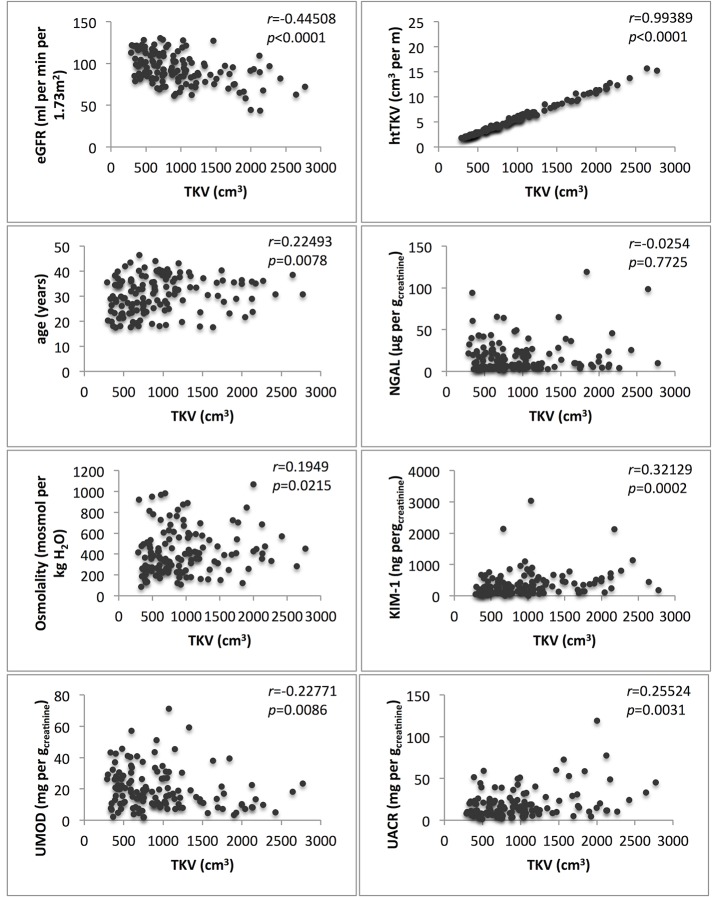
Total kidney volume (TKV) and parameter distribution.